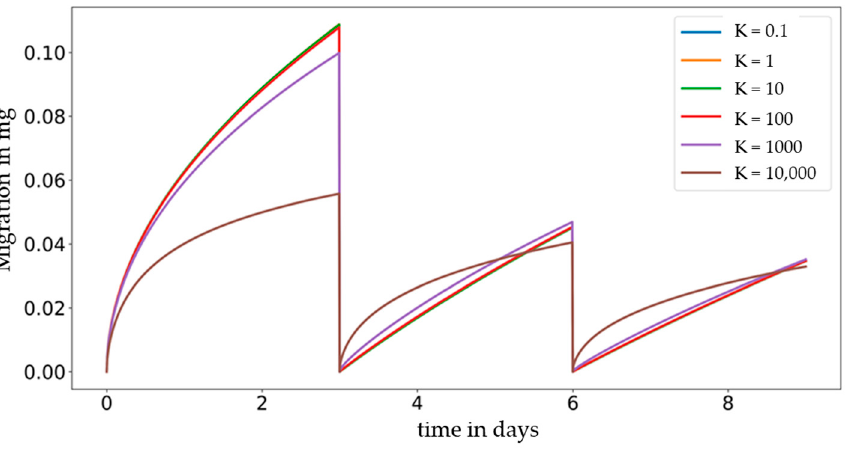
Figure 6. Repeated-use 3 × 72 h (= 3 × 3 days) with diffusion coefficient 10 − 13 cm 2 /s and partition coefficient K = 0.1 to K = 10,000.